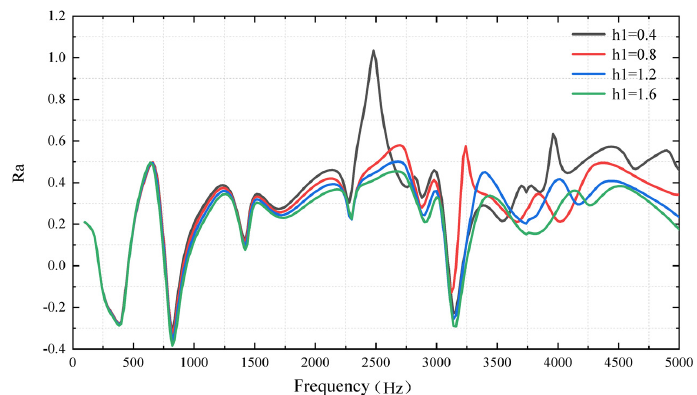
Figure 9. The ratio of quadratic velocity under different truncation thicknesses of ABH.